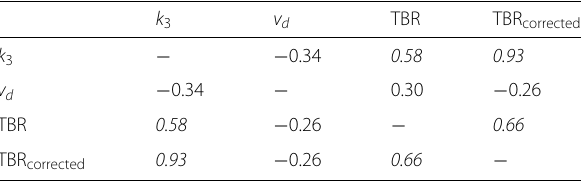
Table 2 Correlation matrix of Pearson correlation coefficients between the tumour-scale parameters across the twenty tumours studied using the 2-h data